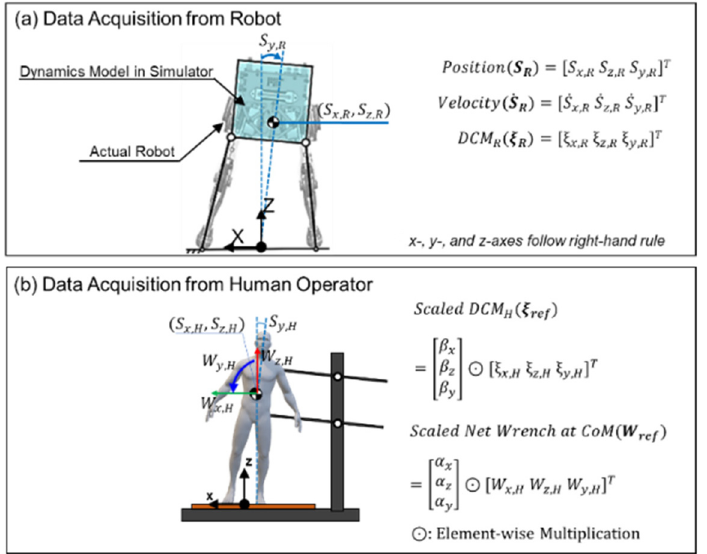
Figure 5. Collected data used to train the balance controller: ( a ) Position, velocity, and DCM collected from the bipedal robot, ( b ) DCM and net wrench data collected from the human operator, which were scaled as shown in Equation (3) to be used for training